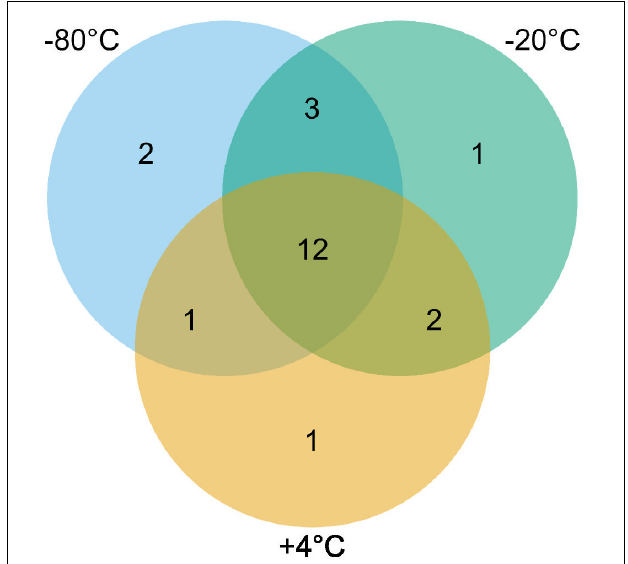
FIGURE 4 | Venn diagram showing the unique and shared thermospore OTUs detected after 7 days incubation at +50 ◦ C in microcosms in each pretreatment (–80 ◦ C, –20 ◦ C, and +4 ◦ C). In total, 22 thermospore OTUs were detected in this study, out of which 12 were detected in all experimental conditions.